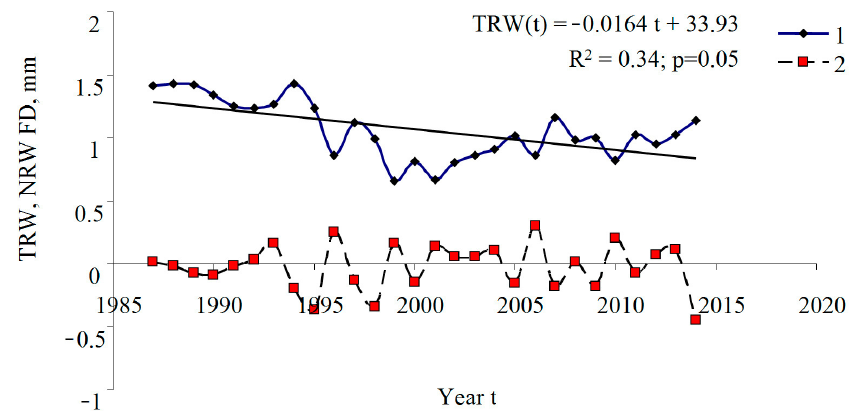
Figure 2. Temporal dynamics of tree-ring widths (TRW) (curve 1) and TRW first differences (FD) (curve 2), sample plot No. 1.